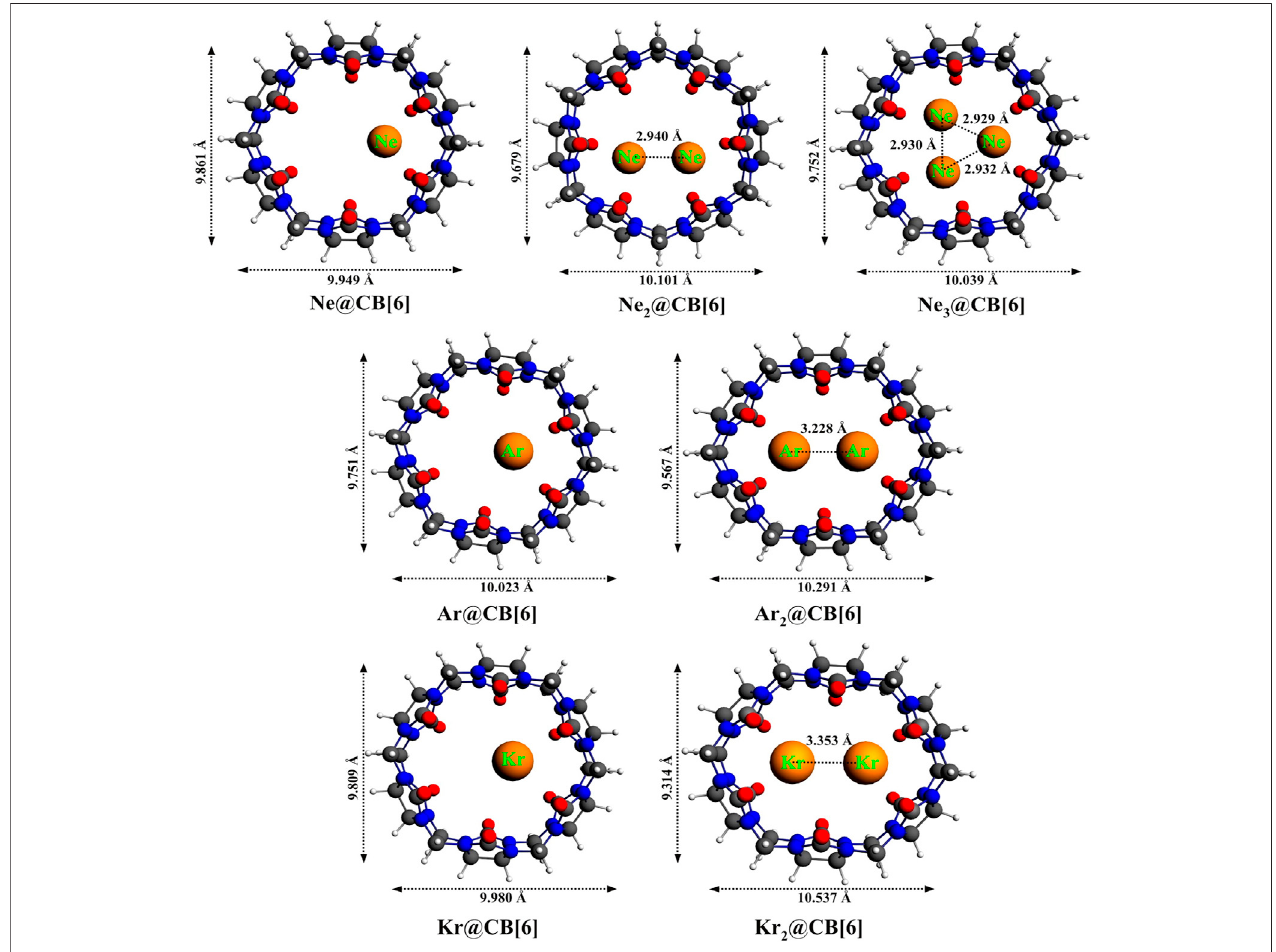
FIGURE 8 | Optimized geometries of noble gas encapsulated CB[6] complexes at the ω B97X-D/6-311G(2d,p) level. (Reprinted with permission from Pan et al., 2015. Copyright© 2015, American Chemical Society.).